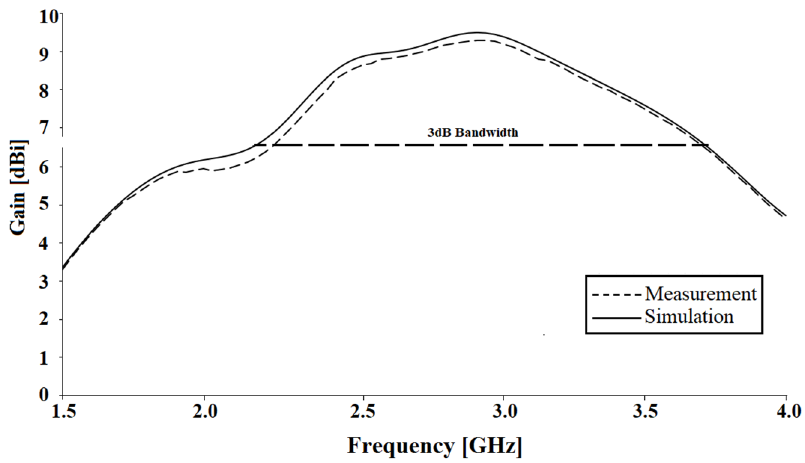
Figure 15. Measured and simulated gains of the proposed antenna.